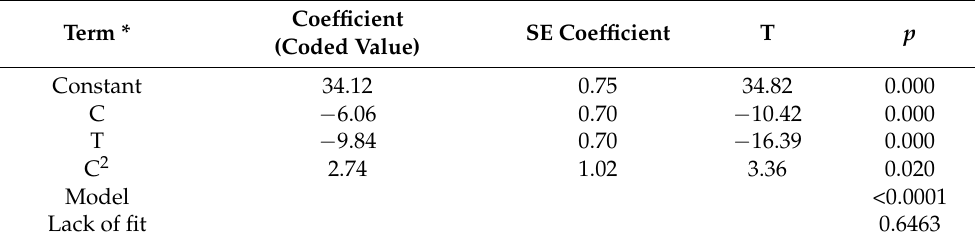
Table 3. Estimated regression coefficients for fiber yield (%) response. Term *